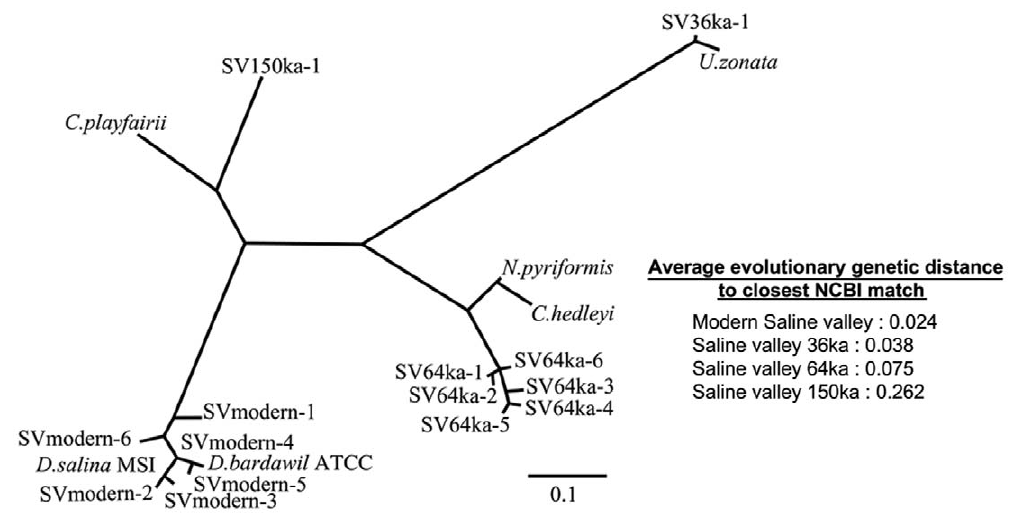
Figure 5. Unrooted Maximum likelihood tree, Saline Valley ITS1 algal sequences and closest matches from extant sequences deposited in the NCBI database. Distinct clusters are observed for the 4 different time periods. Bottom right shows average evolutionary distance between sequences and their closest NCBI match.